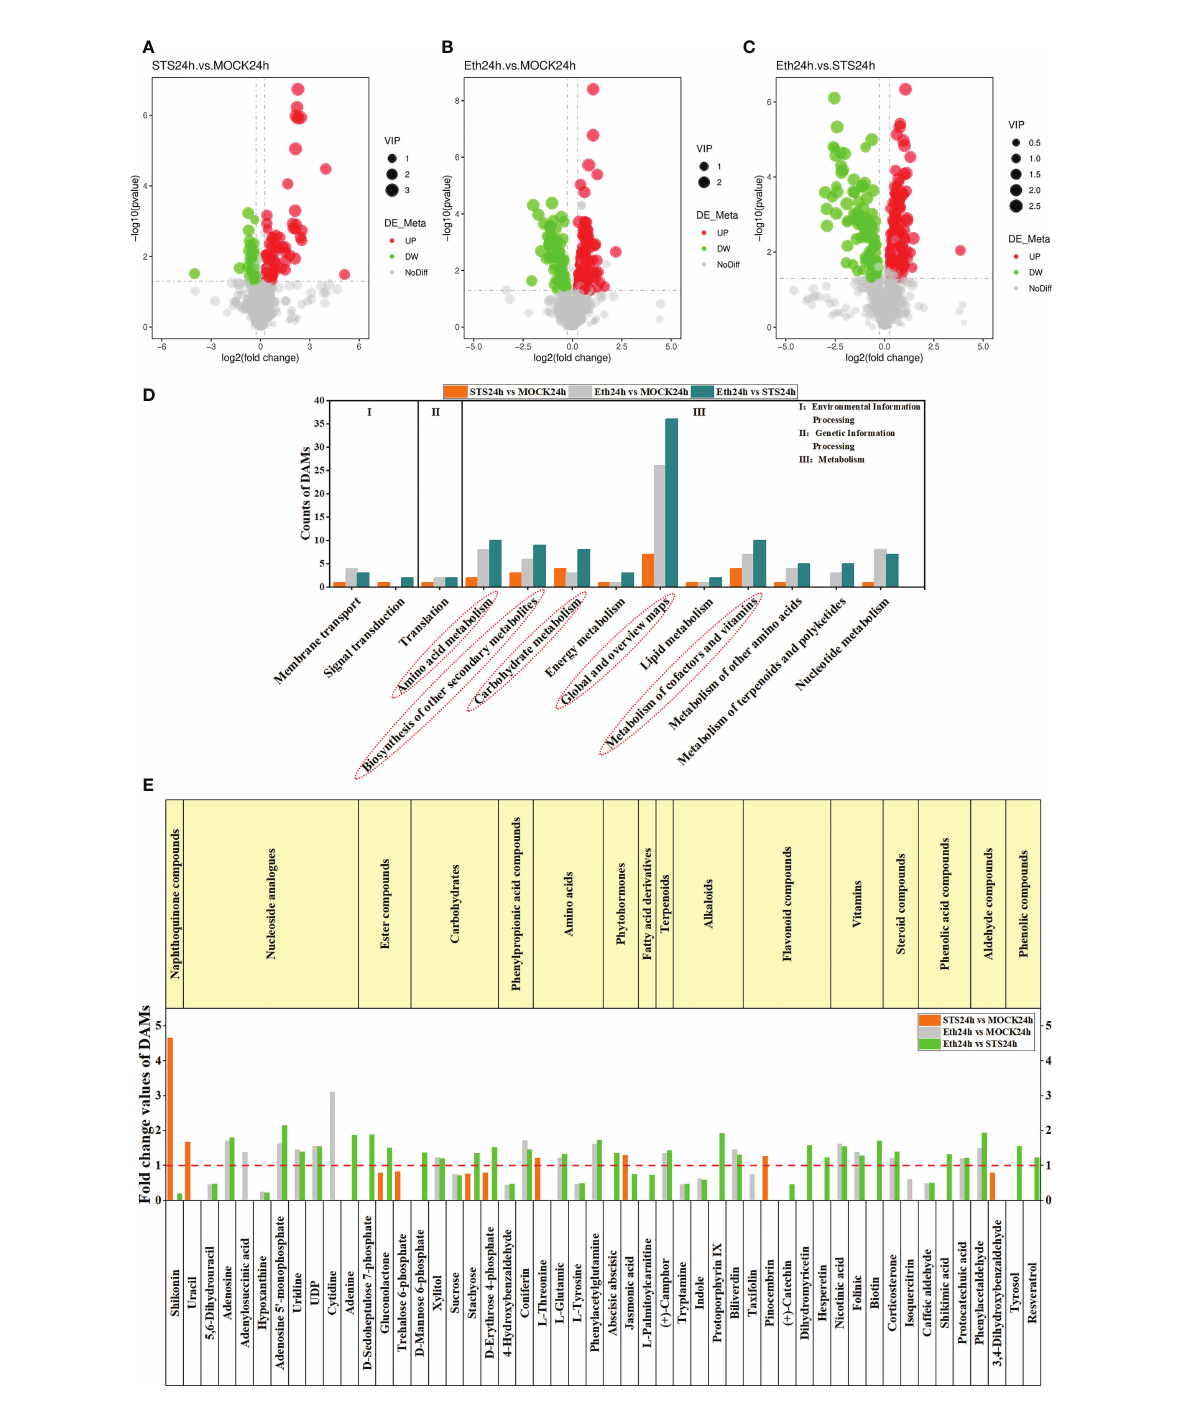
FIGURE 2 Analysis of DAMs in different comparative combinations. (A – C) Volcano plots of DAMs in groups STS24h vs. MOCK24h, ETH24h vs. MOCK24h and ETH24h vs. STS24h. Red represented up-regulated, green represented down-regulated. (D) KEGG enrichment analysis of DAMs in different comparative combinations. The content of the red dashed box was the fi ve KEGG categories with a high number of DAMs. (E) Classi fi cation of the 50 DAMs and the FC values in groups STS24h vs. MOCK24h, ETH24h vs. MOCK24h and ETH24h vs. STS24h. The red dashed line was located at y-axis=1. The upper part of the dashed line indicated upward adjustment of metabolite content and the lower part indicated downward adjustment. The content of the yellow boxes indicated the different classes of